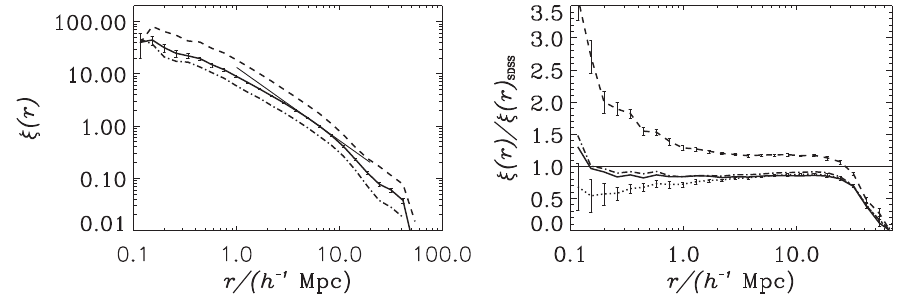
Fig. 2. Left panel: Two-point auto-correlation function for sample m1 with all galax- ies (solid line), red galaxies (dashed line) and blue galaxies (dot-dashed line). For the full sample, a power law fit, (cid:24) = ( r=r 0 ) 1 : 4 , centered at the correlation length scale, r 0 , is shown. Error bars for the full sample are partly smaller than the line thickness. Right panel: Ratio between model correlation functions and SDSS galaxies for the m4 sample. The different semi-analytic mock samples considered are those of C06 (solid line), D07 (dotted line with error bars), F08 (dashed line with error bars), and G11 (dash-dotted